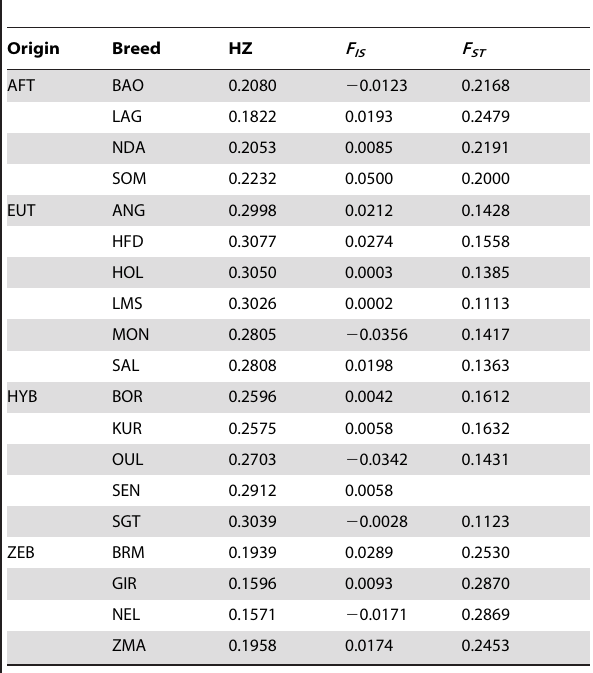
Table 1. Heterozygosity (HZ), inbreeding coefficient (F IS ) for each breed and differentiation (F ST ) of SEN vs other